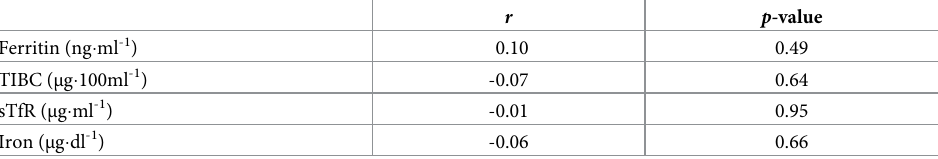
Table 3. Correlations between indices of iron status and (log of) 25(OH)D concentration (n = 50).